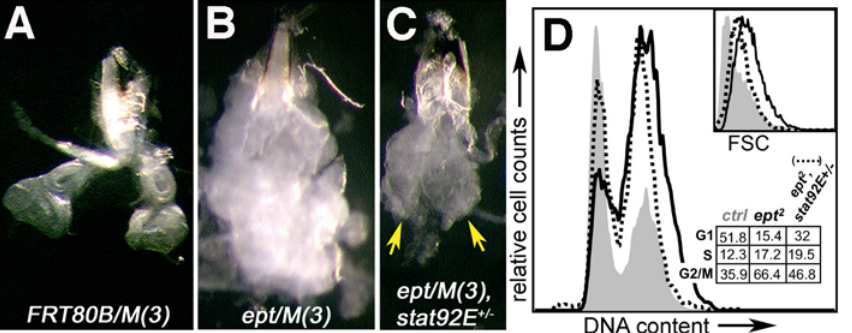
Figure 1. stat92E promotes growth of ept tumors. Bright-field images of (A) control discs [ FRT80B/M(3) ], (B) ept mutant discs [ ept 2 /M(3) ], or ept mutant, stat92E heterozygous discs [ ept 2 /M(3),stat92E 06346 / + ] from wandering-stage larvae. Yellow arrows in (C) denote the two lobes of tissue resembling eye discs. (D) Flow cytometric analysis of control (grey fill), ept 2 /M(3) mutant (black line), and ept 2 /M(3),stat92E 06346 / + (dotted line) eye- antennal discs shows that reducing stat92E gene dosage partially rescues of cell cycle and cell size (inset) defects in ept 2 mutant tissues. Percentages of cells in each stage of the cell cycle are indicated. The FACS data are representative of multiple experiments.